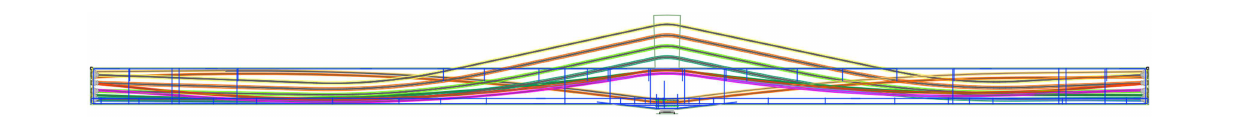
FIGURE 6 | Counteracting additional